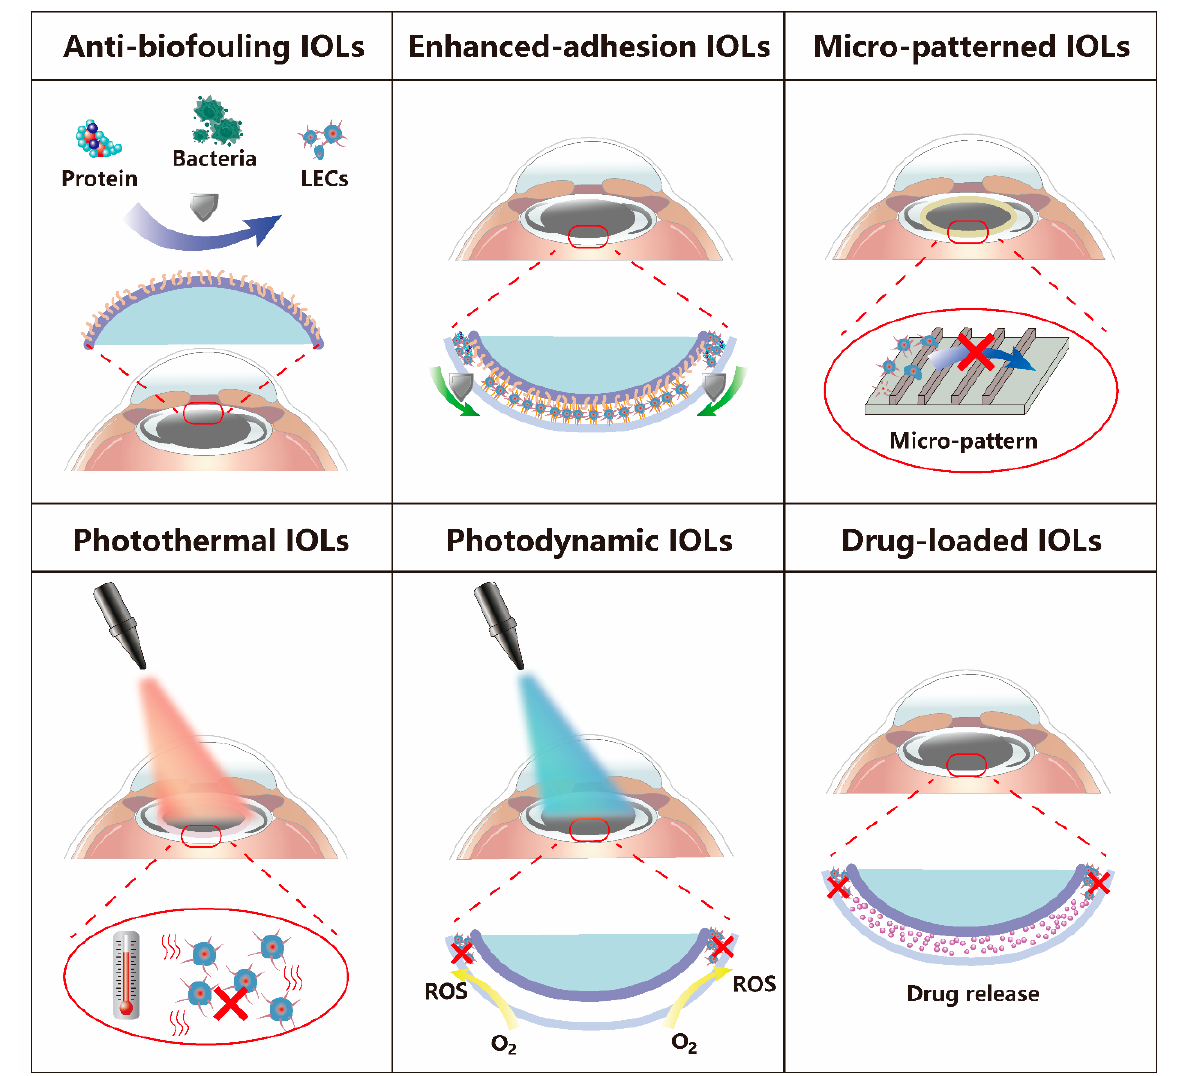
Figure 2. Schematic illustration of the main types of IOLs used for PCO prophylaxis.